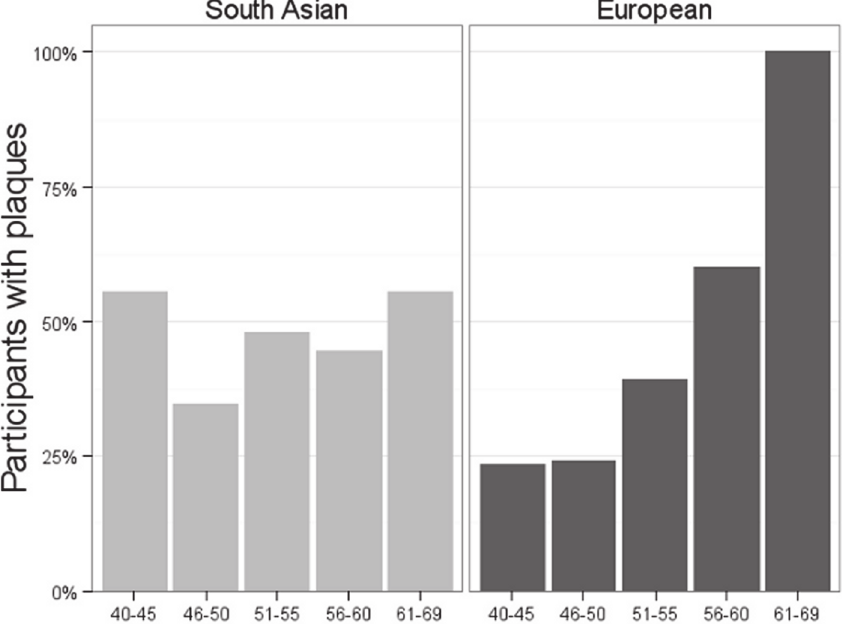
Fig 2. Presence of carotid plaque by ethnicity and age * . * Percentage of participants within each category. Number of participants in each age category (South Asian, European): 40 – 45 (36, 30); 46 – 50